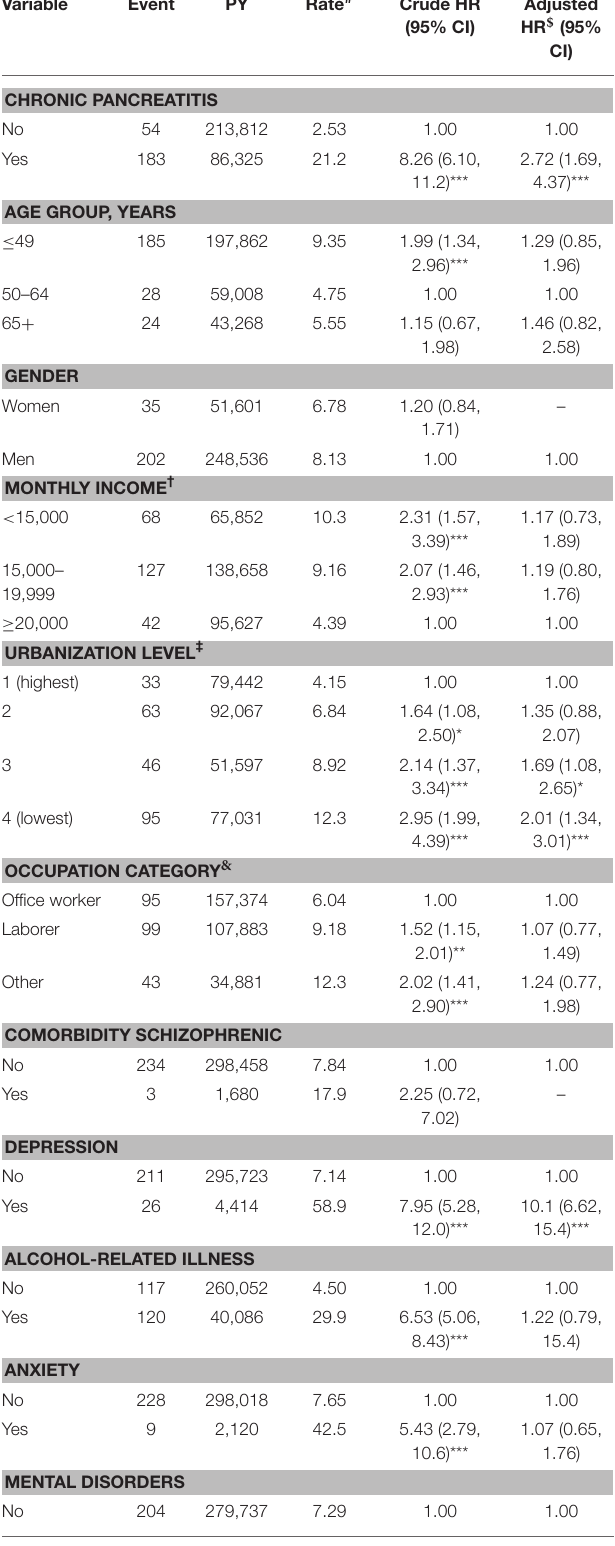
TABLE 2 | Incidence and risk factors for suicide